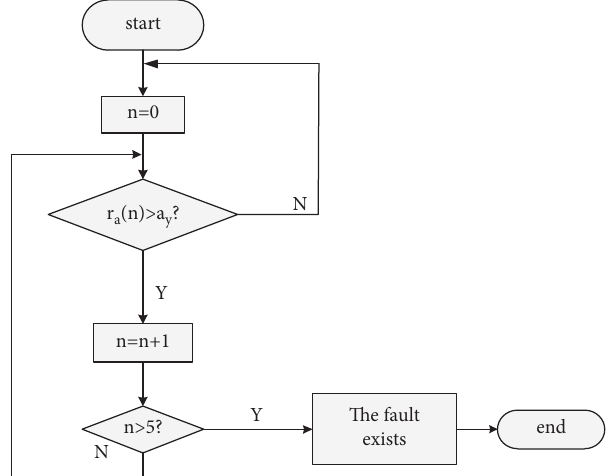
Figure 11: The flow chart of the stability